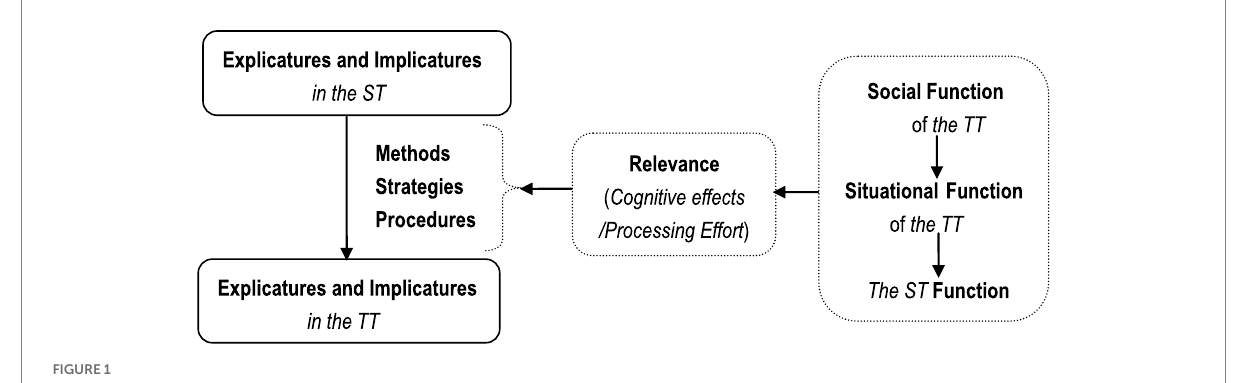
FIGURE 1 Mechanism of decision-making in